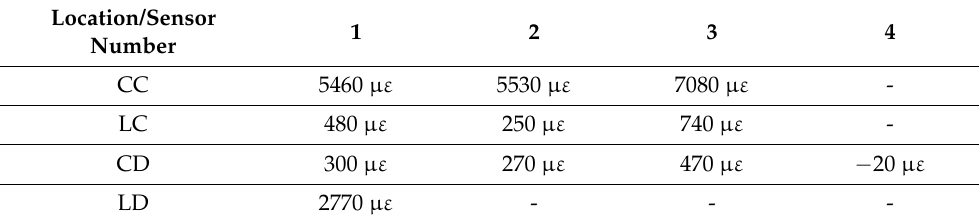
Table 2. Strain registered by FBG sensors for 1-bar internal